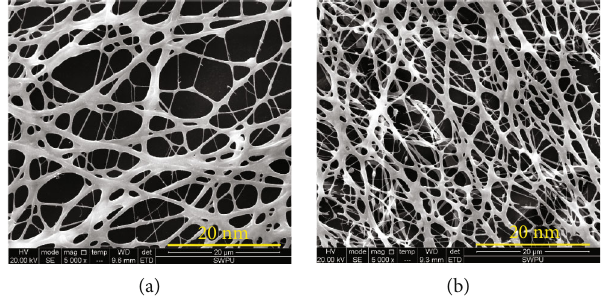
Figure 4: Structure of HPAM (a) and HPDS (b) solution.